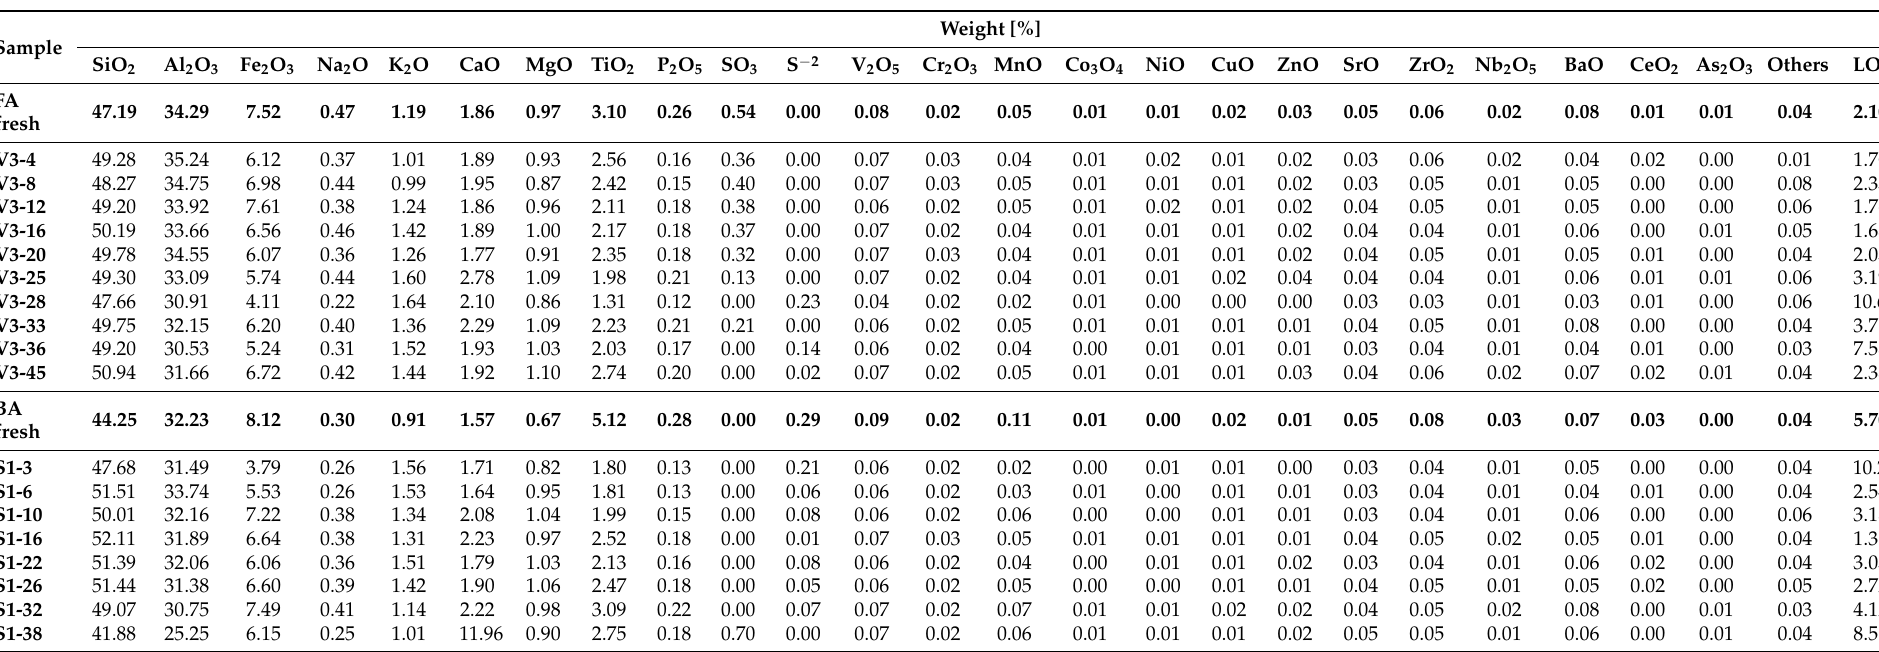
Table 2. Oxide Composition of Fresh FA, Bottom Ash (BA) and Selected Deposit Samples from Core Boreholes V3 and S1 in locality Pansk ý les by XRF analysis; measurement errors were below 1